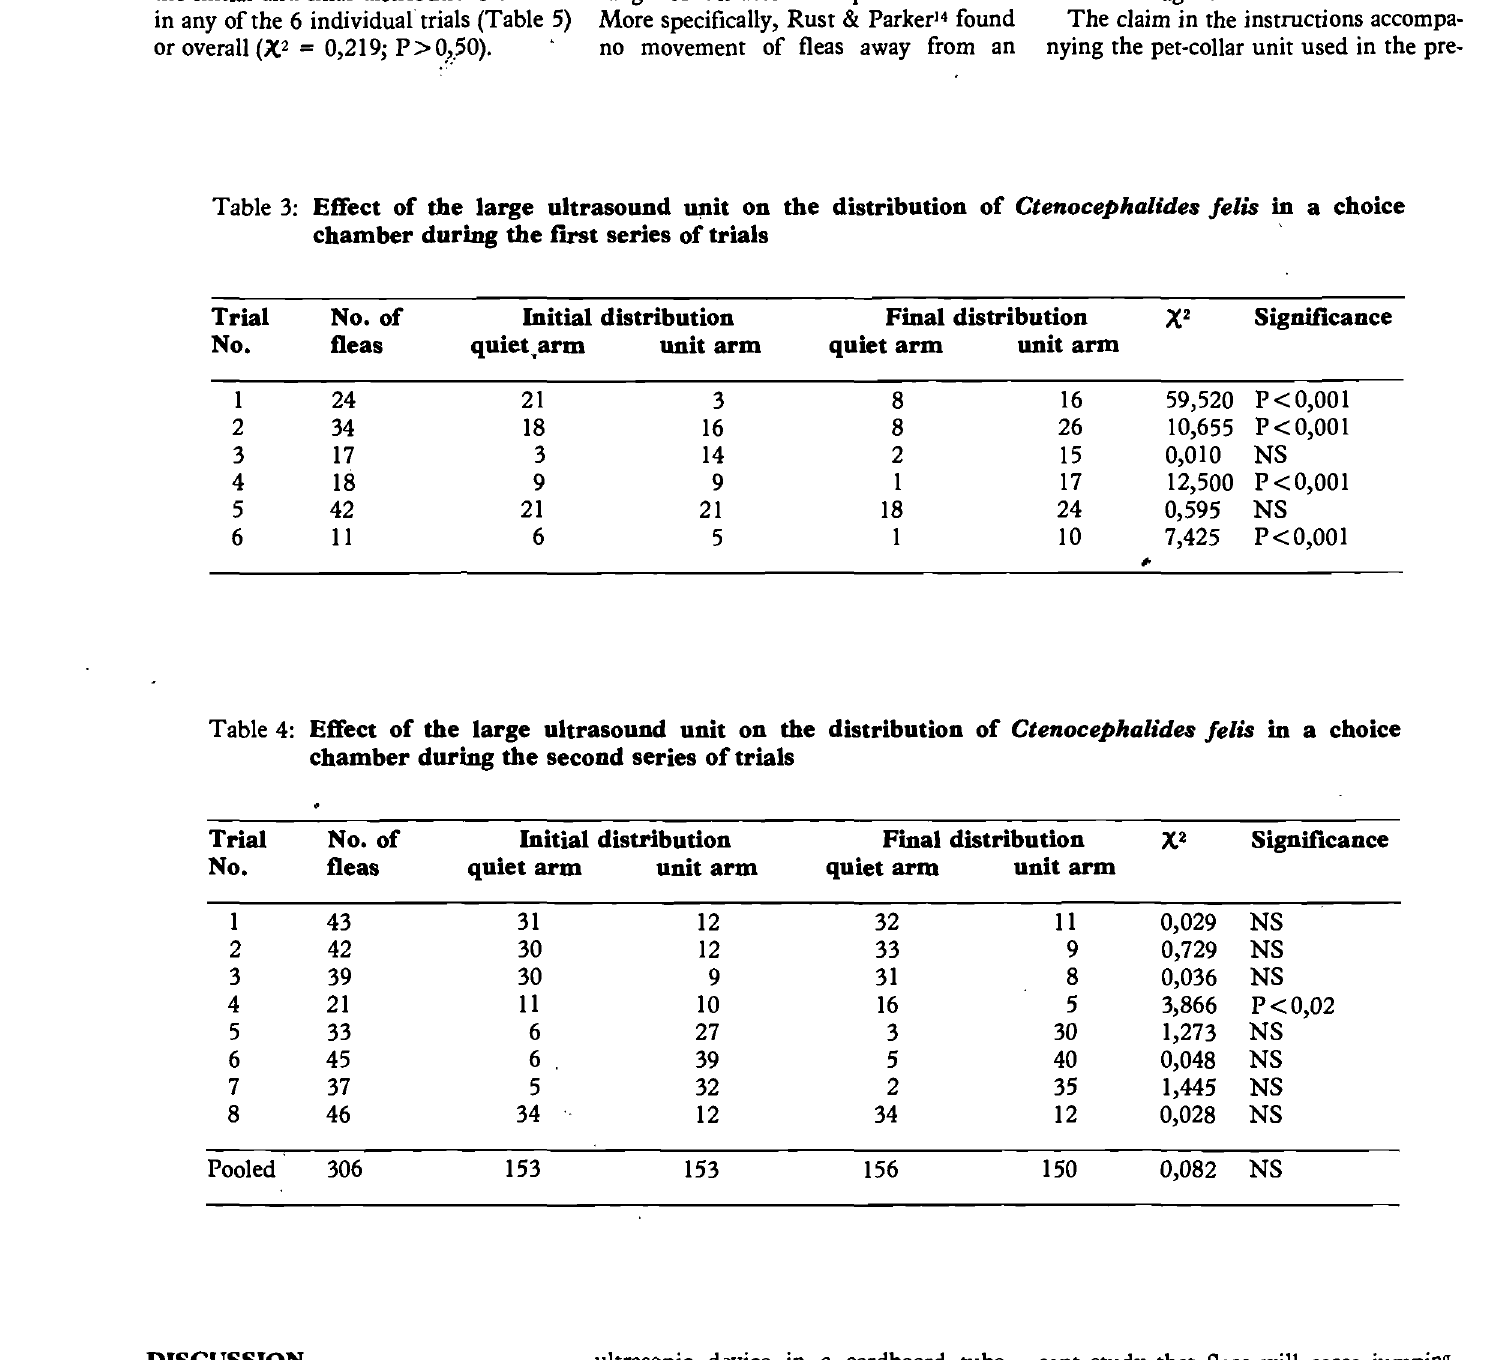
Table 3: Effect of the large ultrasound ~it on the distribution of Ctenocephalides felis in a choice chamber during the '-ll'St series of trials